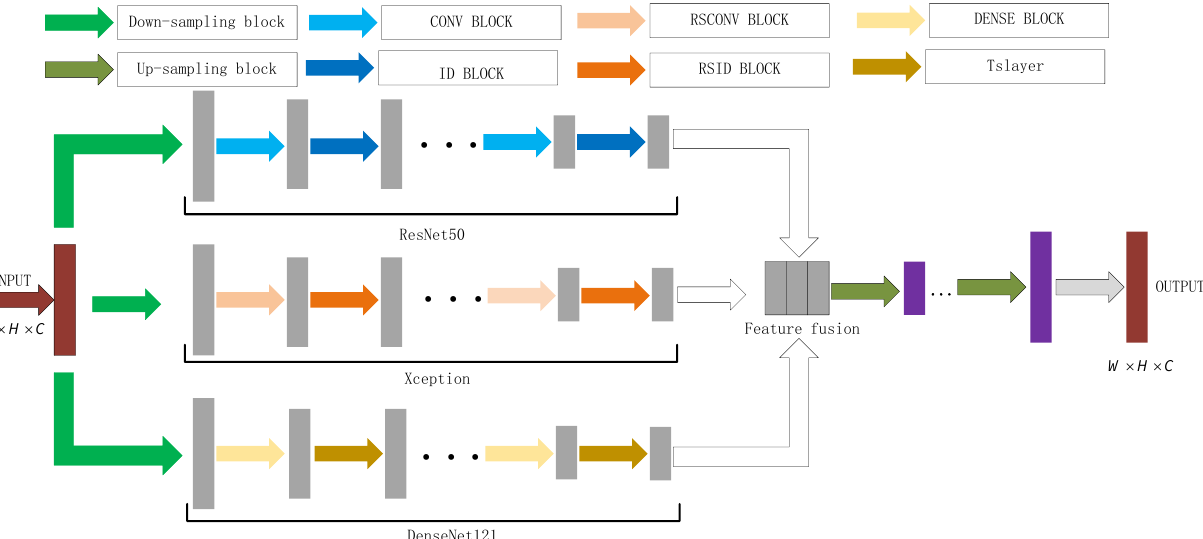
Figure 2. Deep multi-feature transfer network Fourier ptychographic microscopy imaging recon- struction model.